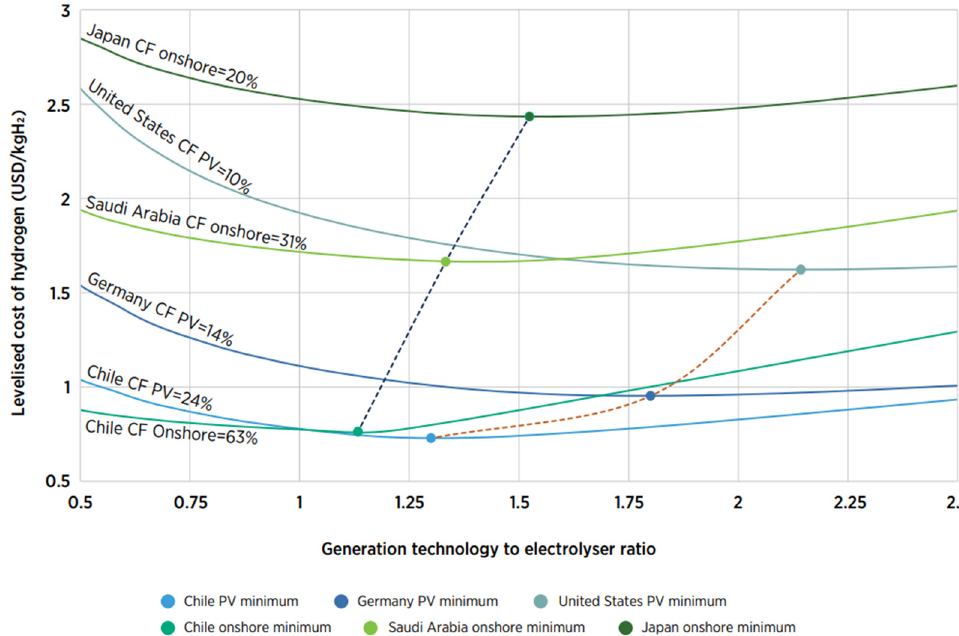
Figure 5. LCOH produced by different means vs. generation technology ratio and CF for NZE scenario [19].